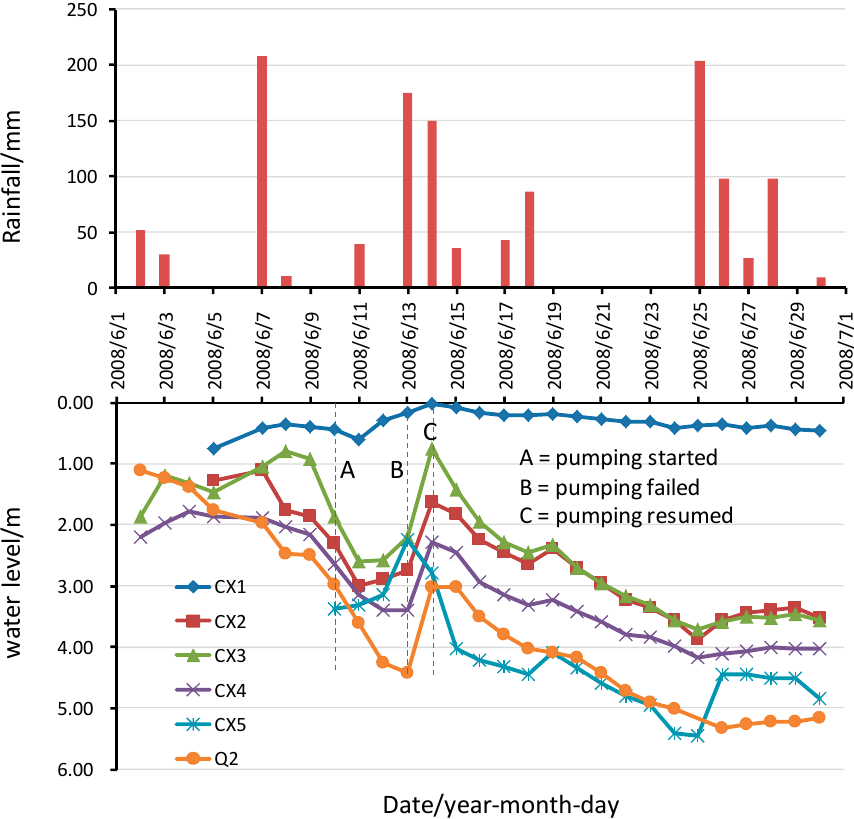
Figure 5. Change of water level with time and rainfall conditions.